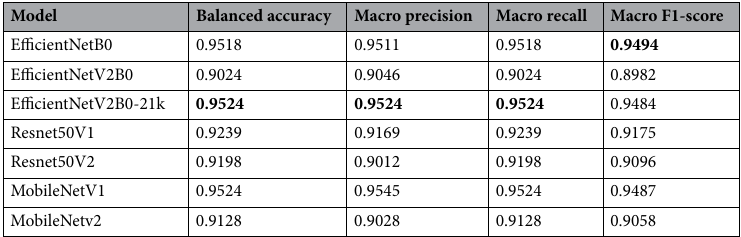
Table 8. Breast cancer grading results on the test set using the final retrained model (using all training images). The EfficientNetV2B0-21k aligns with the CV performance result (Table 7), remaining as the CNN model with the highest balanced accuracy, macro precision, and macro recall. Similarly, the MobileNetV1 achieved the highest balanced accuracy, macro precision, and macro recall, placing it as the second-best CNN model. Significant values are in